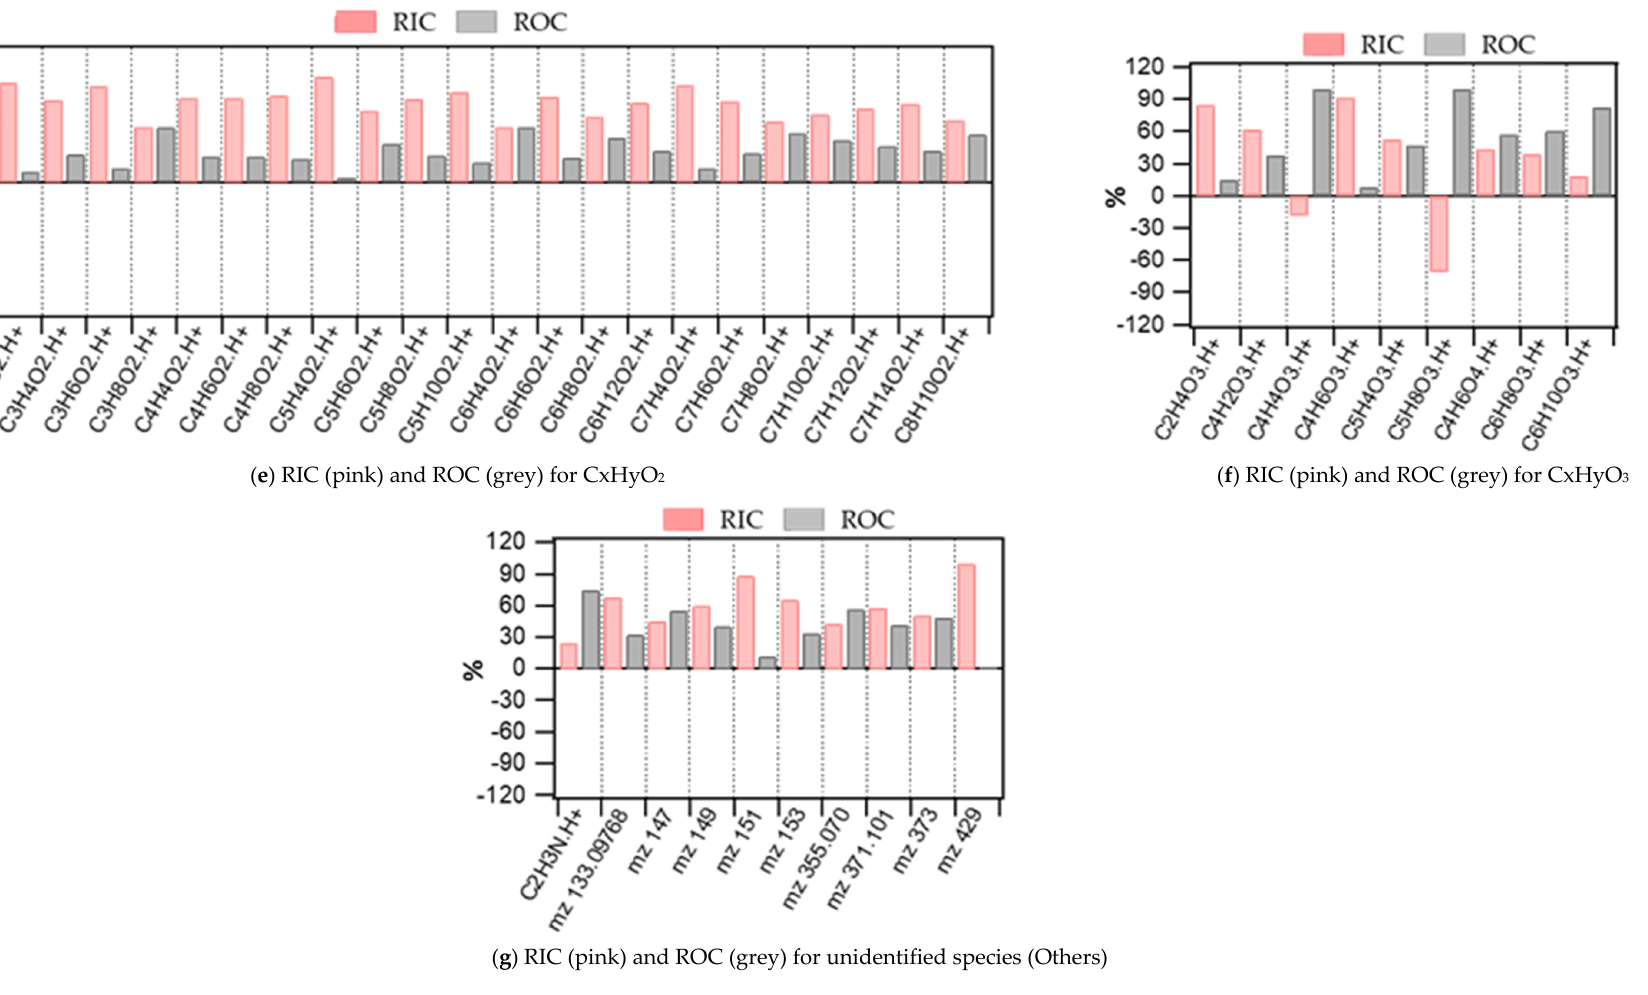
Figure 7. ( a – g ) Average relative indoor and outdoor contributions (RIC and ROC, respectively) for all compounds during the intensive campaign.